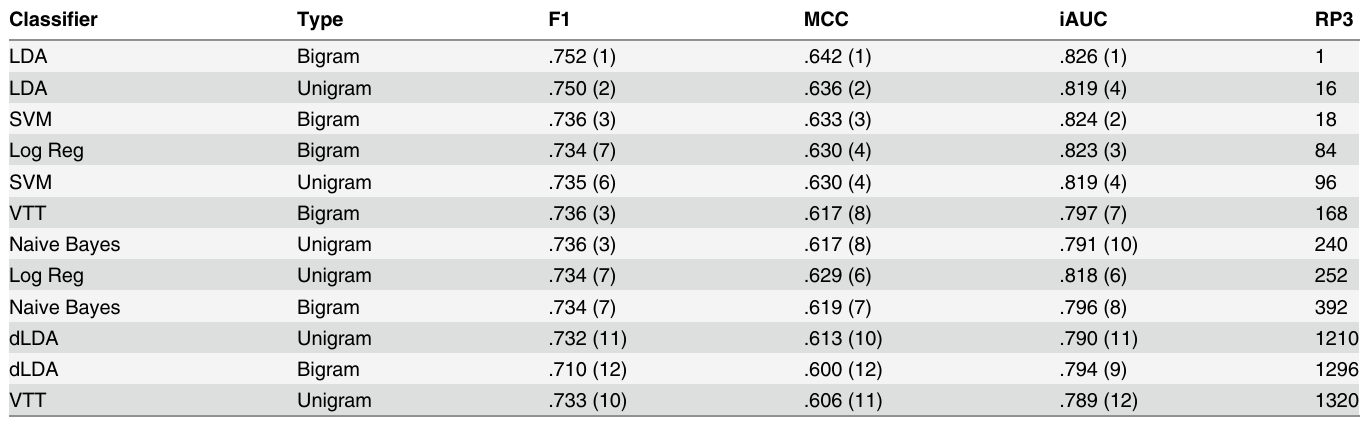
Table 4. Sentence classification performance. Performance for both unigram and bigram runs on non-transformed features according to F1, MCC, and iAUC performance measures. The rank of the classifiers according to each measure is reported in parenthesis in the respective column. Classifiers are or- dered according to the rank product (RP3) of the three measures (last column). Classi fi